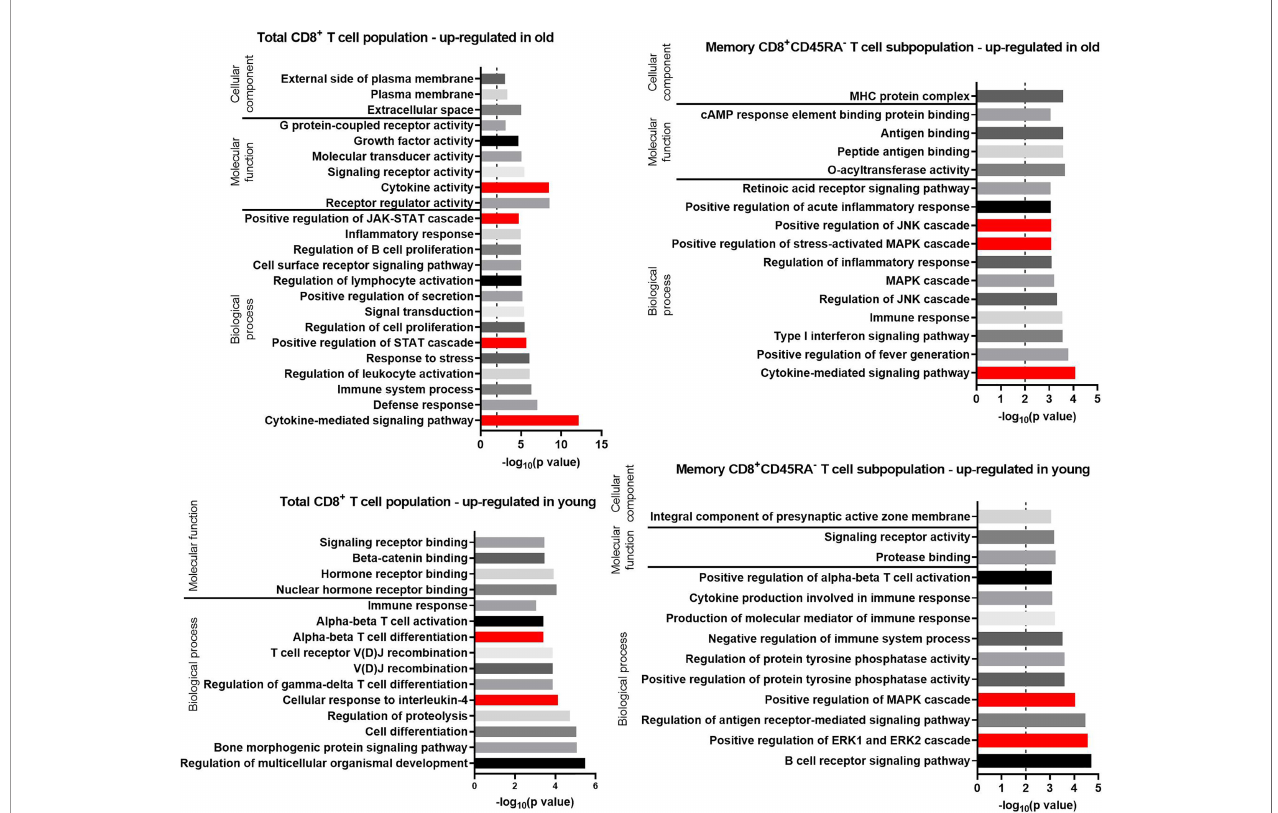
FIGURE 5 | GO terms for transcripts with an up-regulated expression in the total CD8 + T cell population and the memory CD8 + T cell subpopulation in old and young donors retrieved with GOrilla. The resulting GO terms were classi fi ed as biological process, molecular function, or cellular component. The dotted line is indicating − log 10 (p value) = 2, which corresponds to a p value of